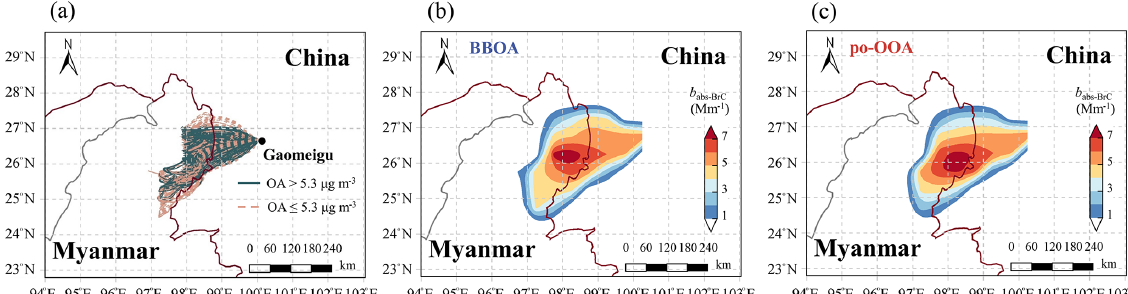
Figure 6. (a) The 72h backward trajectories of Gaomeigu from 08:00 on 14 March 2018 to 23:00 on 31 March 2018. (b, c) Concentration- weighted trajectory (CWT) maps of b abs-BrC at 370nm (Mm − 1 ) from BBOA and po-OOA, respectively.